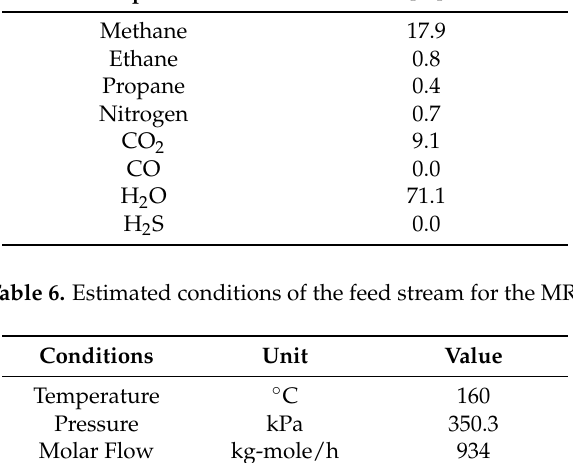
Table 5. Estimated composition of feed stream for the MR.